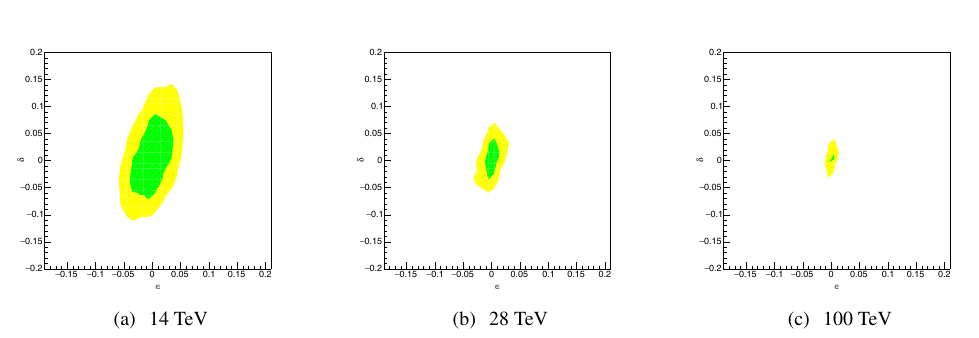
Figure 2. Combined constraints on the (cid:31) and δ parameters for SR and NR regions from the t-channel single top Figure 1. Constraints on the (cid:31) and δ parameters from the t-channel CS for the 14 TeV collision energy measured quark production for di ff erent collision energies. Green and yellow arias correspond to exclusion limits at 68% with 5% uncertainty. Green and yellow arias correspond to exclusion limits at 68% and 95% CL. and 95%